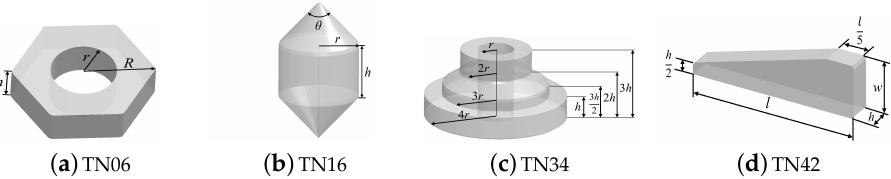
Figure 2. The selected four templates with commonly existing symmetry types in industrial scenarios: ( a ) TN06: Finite; ( b ) TN16: Revolution with rotoreflection invariance; ( c ) TN34: Revolution without rotoreflection invariance; ( d ) TN42: